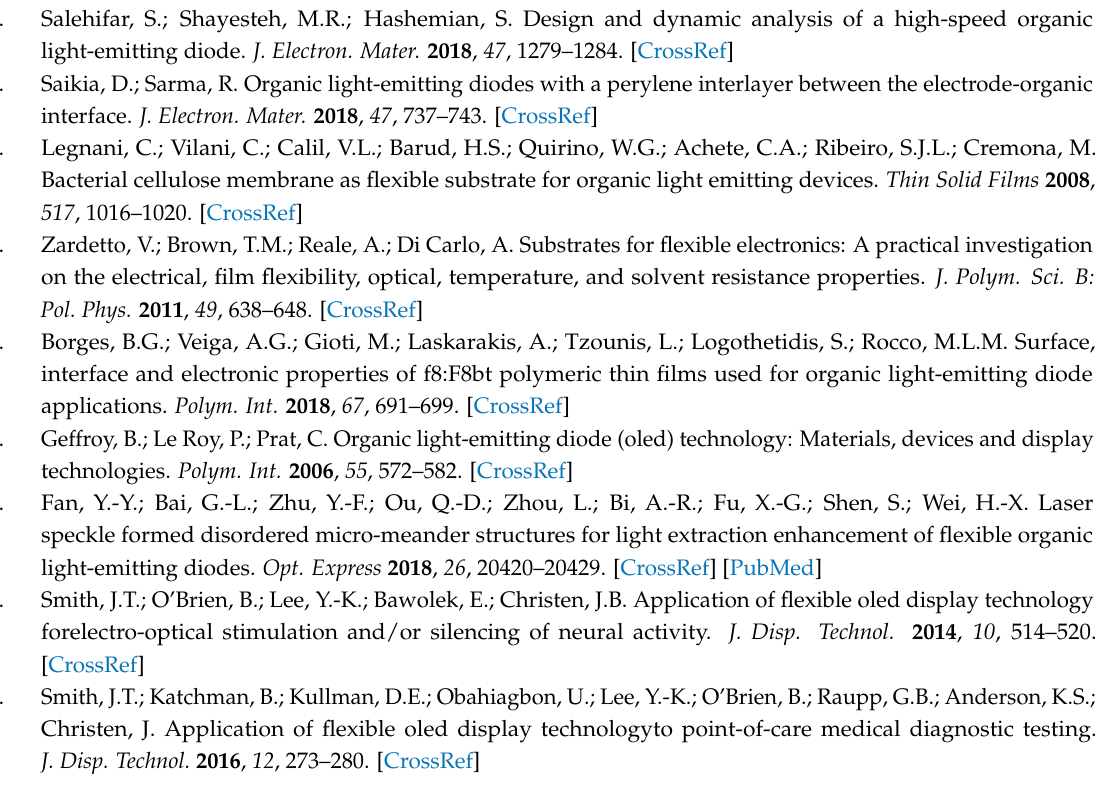
Figure S1: The proton nuclear magnetic resonance ( 1 H-NMR) spectra of (a) NFC and (b) ANFC, Figure S2: Surface roughness and morphological stability of neat ANFC film, Neat ABPE-10 film, and ANFC/ABPE-10 composite film (68%